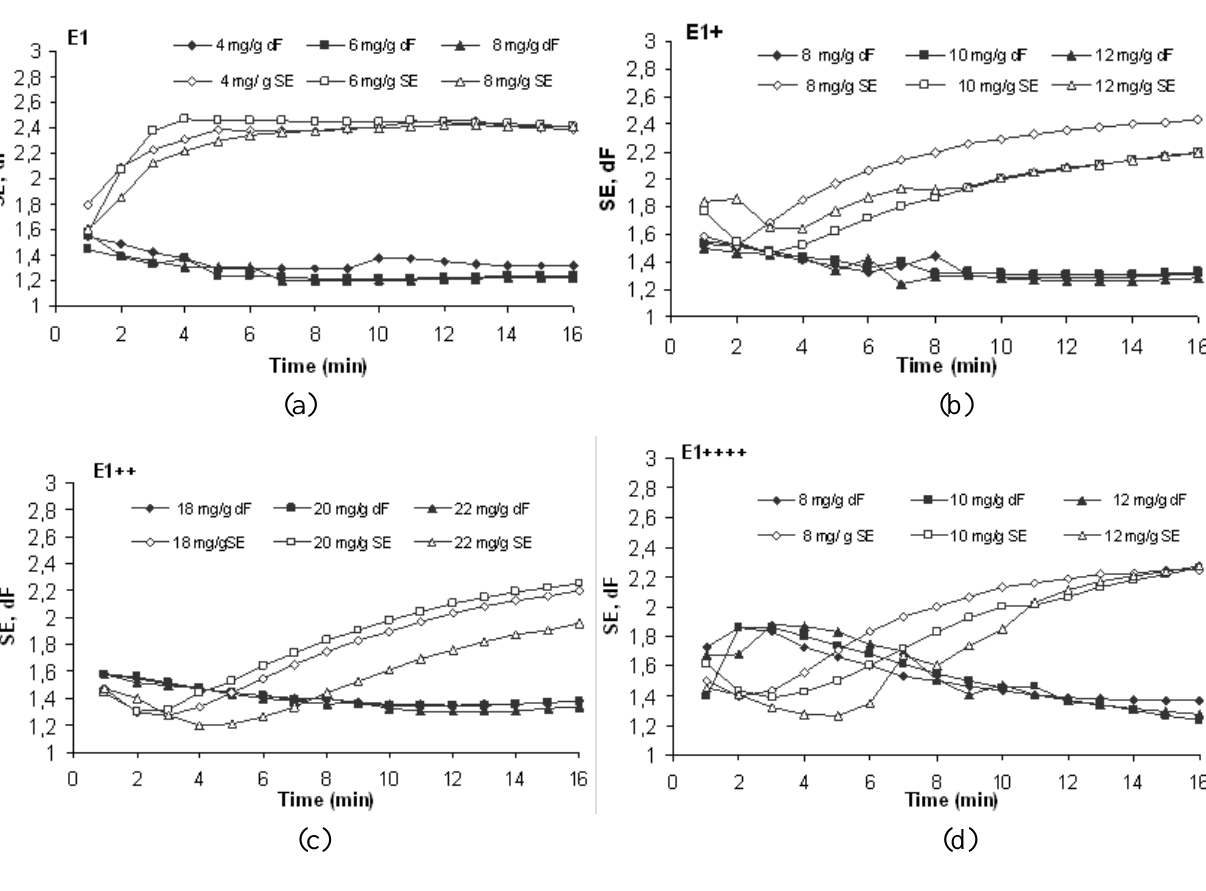
Figure 6. Evolution of flocs structure with time (d